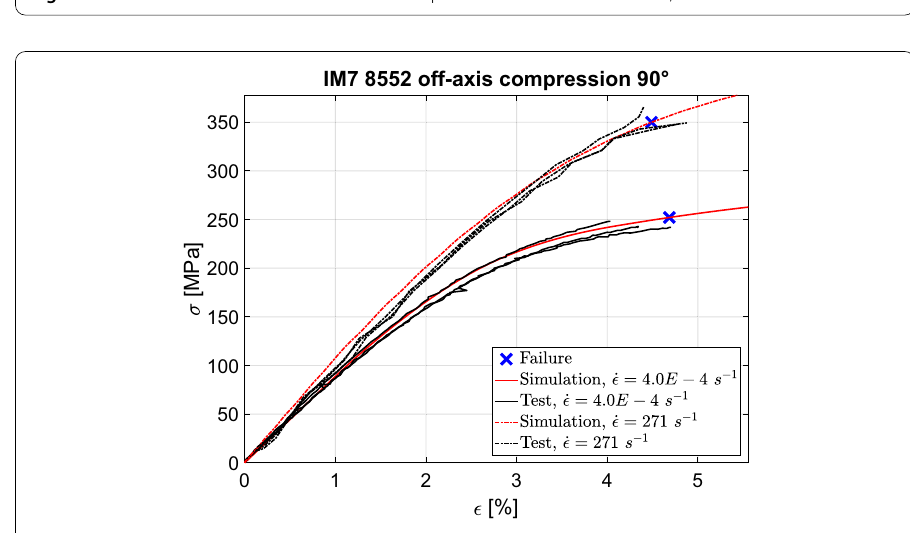
Fig. 21 True stress–true strain curves for the compression tests and simulations, 90 ◦